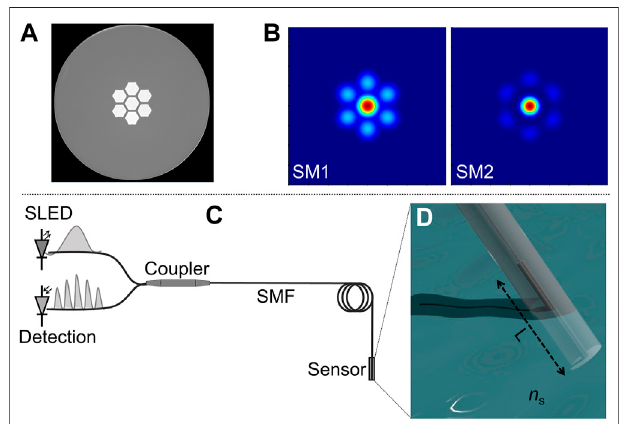
FIGURE 1 | (A) Cross section of the multicore fi ber used in the experiments. (B) Pro fi le of the two supermodes (SM) excited in the MCF. (C) Schematic representation of the interrogation system; the injected and re fl ected light from the device are illustrated with a broad and multiple peak “ spectrum ” , respectively. (D) Illustration of the sensor immersed in a sample with refractive index of ns; L is the length of the MCF segment.